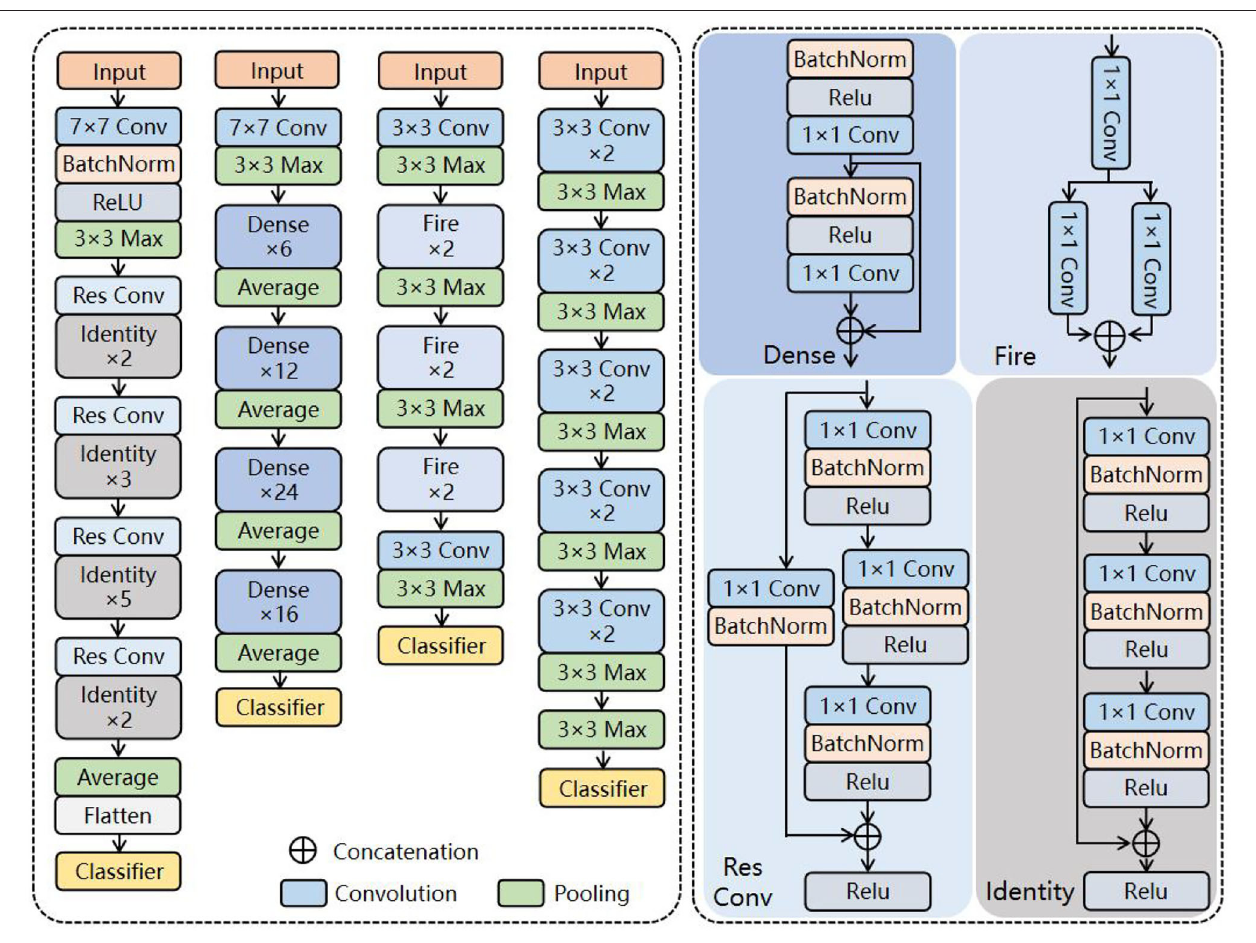
FIGURE 4 | Backbone of proposed